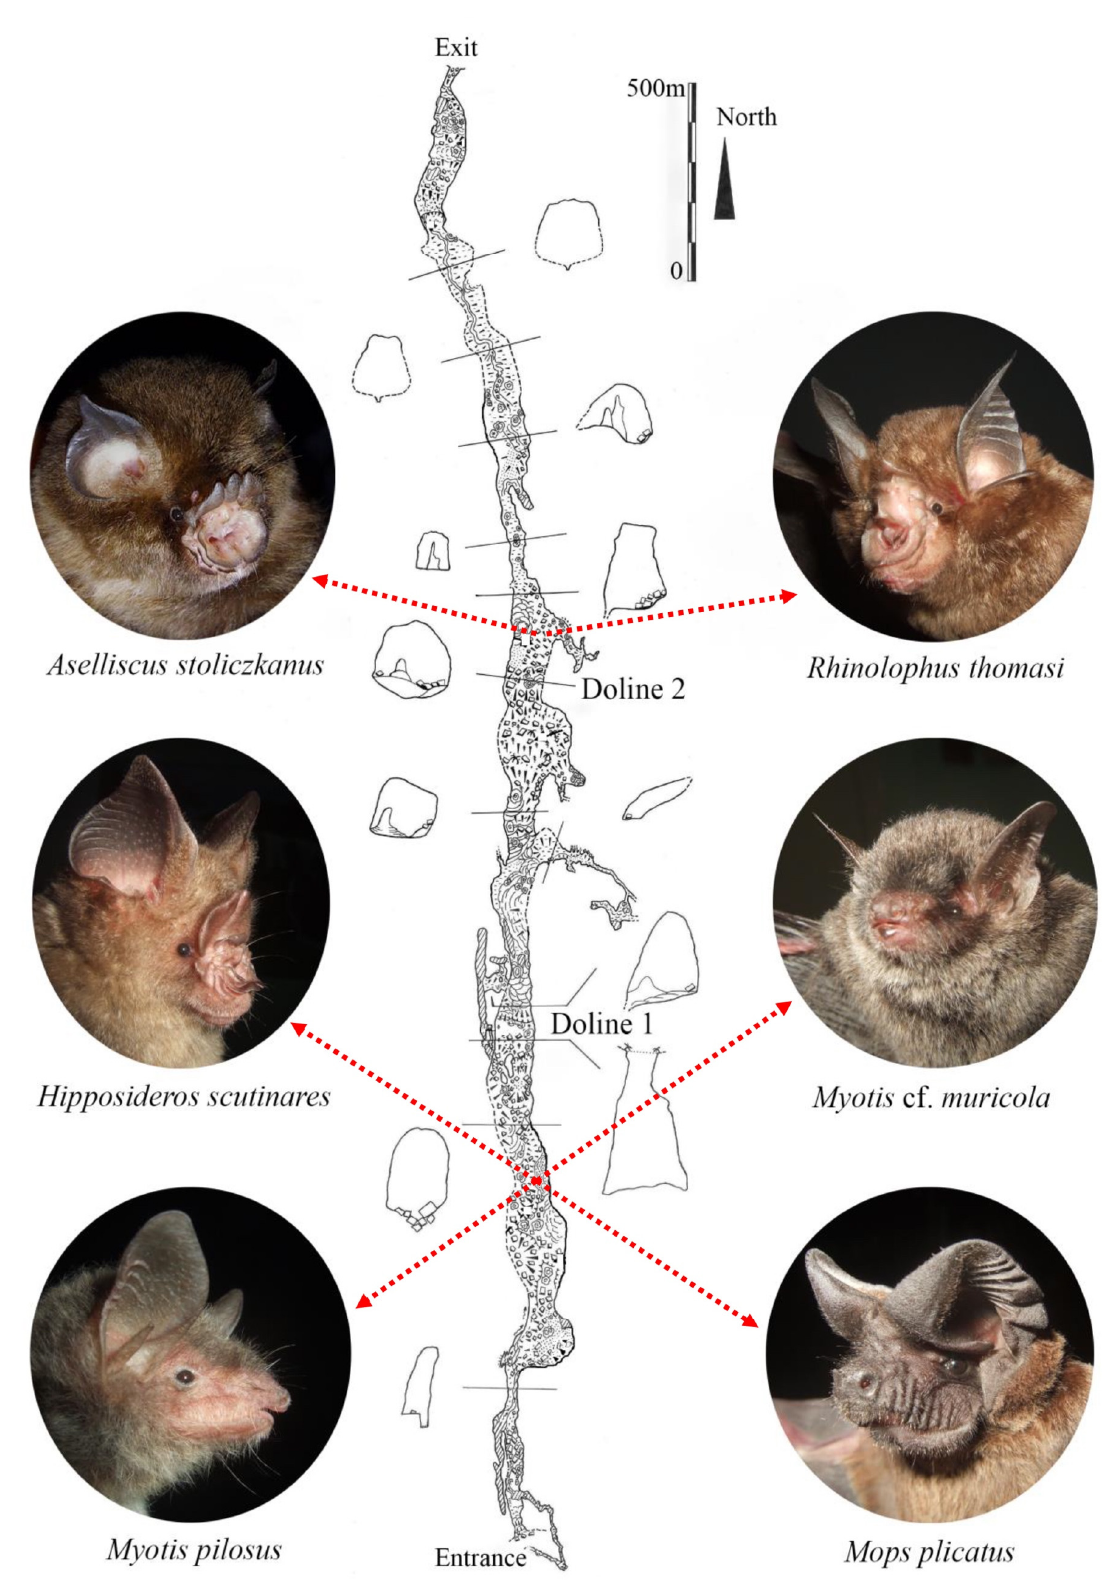
Figure 5. A map of Son Doong Cave with bat species captured at each netting site. Background map: Debora